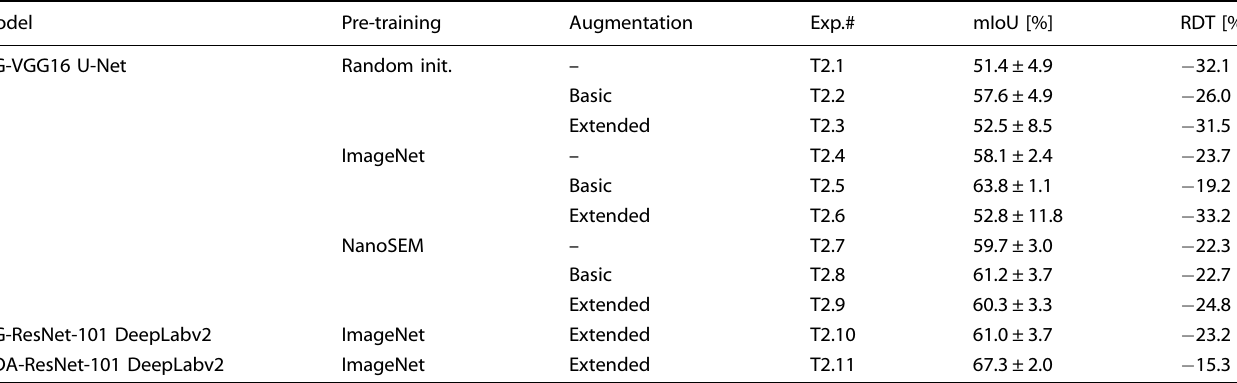
The given mIoU is always averaged over the fi ve folds used for cross-validation. NanoSEM refers to the two-step pre-training introduced in the section “ Pre- training and fi ne-tuning procedure ” . Details about the augmentation pipelines are given in the section “ Data augmentation ” and in Supplementary Table